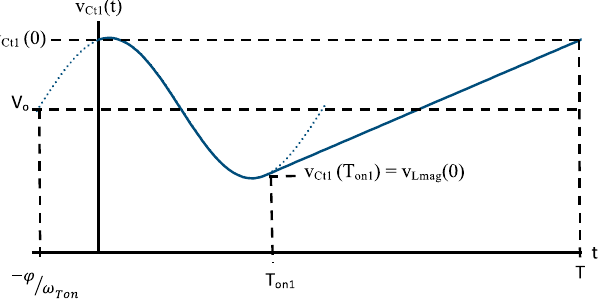
( t ) during a switching period. Figure 7. Evolution of the voltage across the tuning capacitor v (cid:2887) (cid:3178)(cid:3117) (t) during a switching period. (t) during a switching period. t1 (cid:3178)(cid:3117)